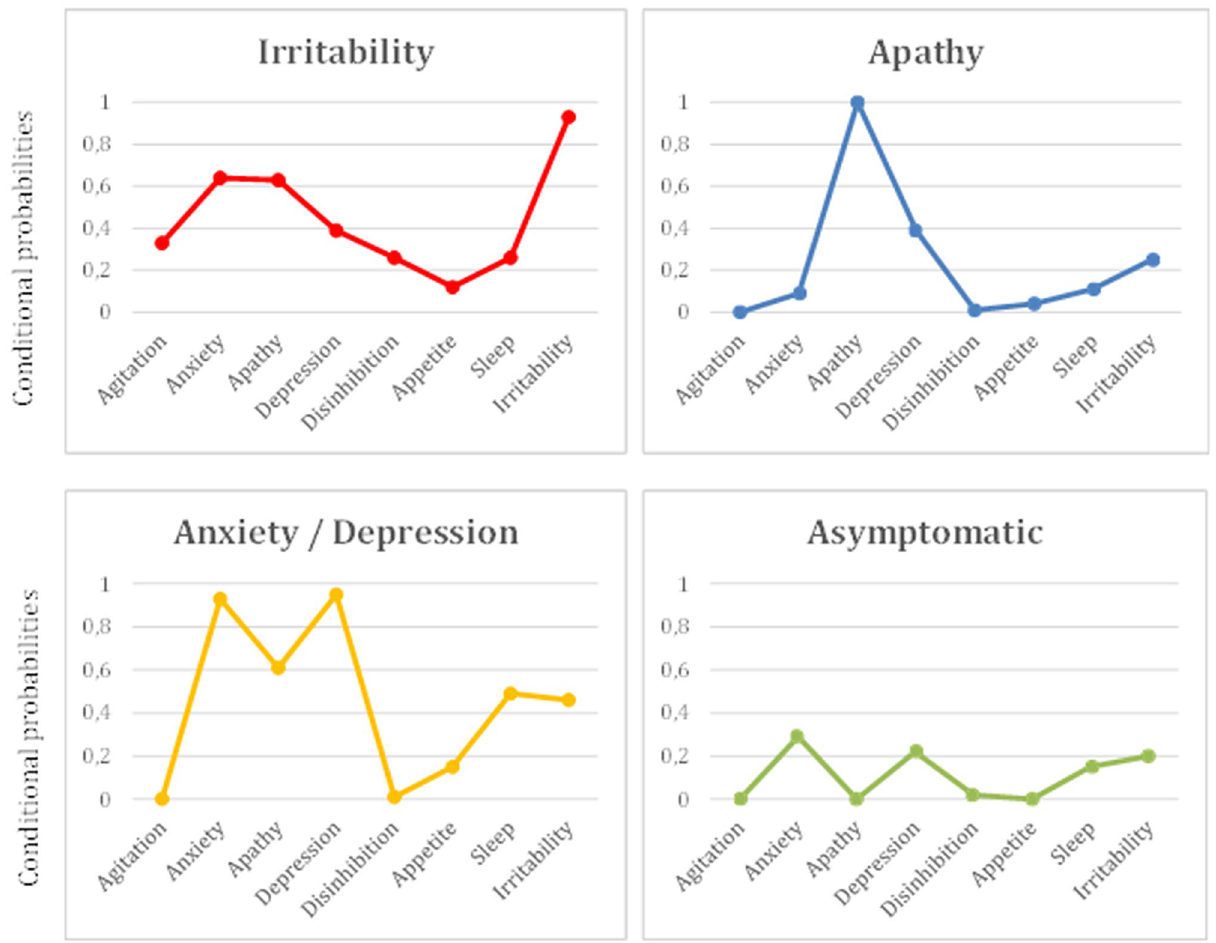
Figure 1. Profile plots represent estimated conditional probabilities (y-axis) observed in the latent class analysis (LCA) for the domains of the Neuropsychiatric Inventory-Questionnaire (NPI-Q; x-axis), displaying the 4-class solution: Irritability, Apathy, Anxiety/Depression and